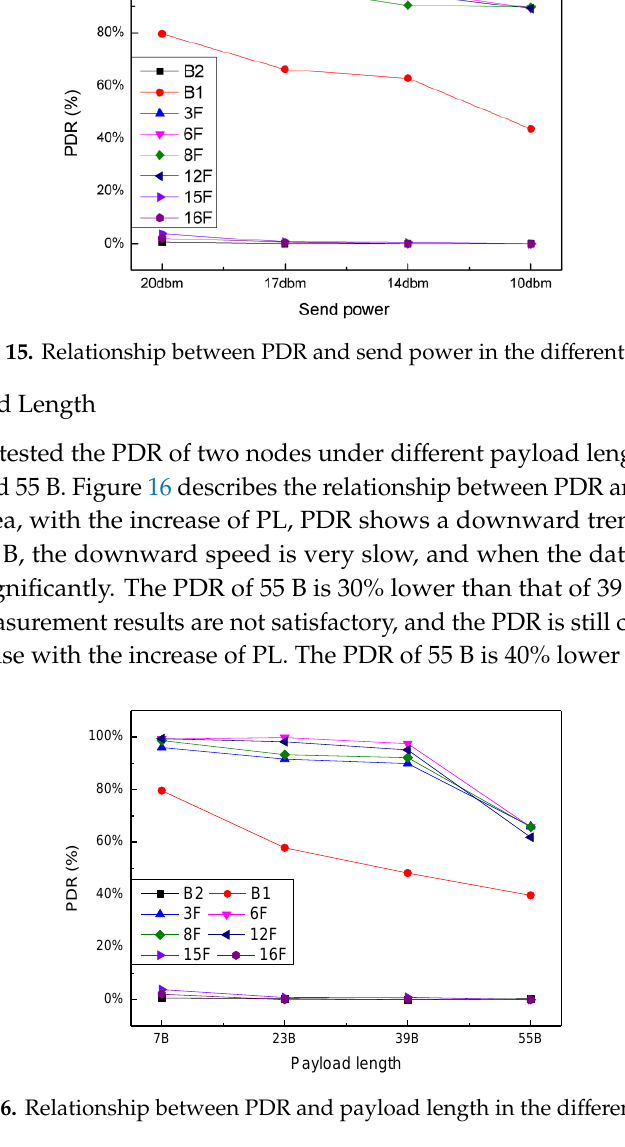
Figure 14. Relationship between PDR and air rate in the same floor.